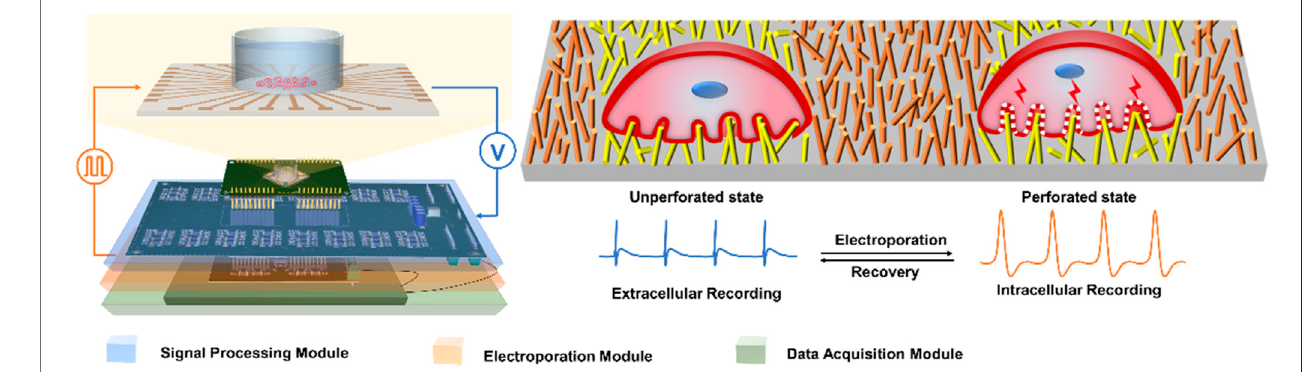
FIGURE 1 | Schematic of integrated electrical signal recording and electrical pulse regulating system based on NPMEA. The multifunctional recording and regulating system shows that the hardware module connected to a NPMEA sensor. The cell on the left is in an unperforated state, the electrode records extracellular electricalsignals.Thecellontherightisinaperforatedstate,andtheelectroderecordsintracellularelectricalsignals.Areversibleelectroporationisappliedtothecellthat converts the electrode from extracellular (blue) to intracellular recording (orange).